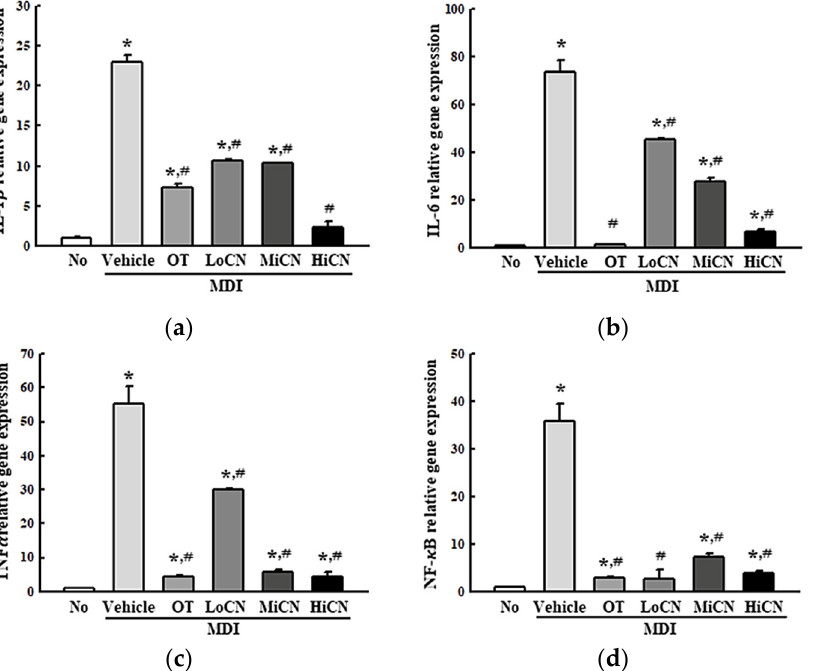
Figure 5. mRNA level of inflammatory cytokines. After collecting the total RNA from MDI stimulated 3T3-L1 adipocytes treated with α -cubebenol, the levels of TNF- α , IL-6, IL-1 β , and NF- κ B mRNA were quantified by RT-qPCR using the specific primers. Two to three dishes per group were used to prepare the total RNAs, and qRT-PCR was assayed in dupli- cate for each sample. The data represent the means ± SD of three replicates. * indicates p < 0.05 compared to the No treated group. # indicates p < 0.05 compared to the MDI + Vehicle treated group. OT, orlistat; MDI, adipogenic cocktail consisting of 3-isobutyl-1-methylxanthine, dexamethasone, and insulin; LoCN, low concentration (7.5 μ g/mL) of α -cubebenol; MiCN, middle concentration (15 μ g/mL) of α -cubebenol; HiCN, high concentration (30 μ g/mL) of α -cubebenol.